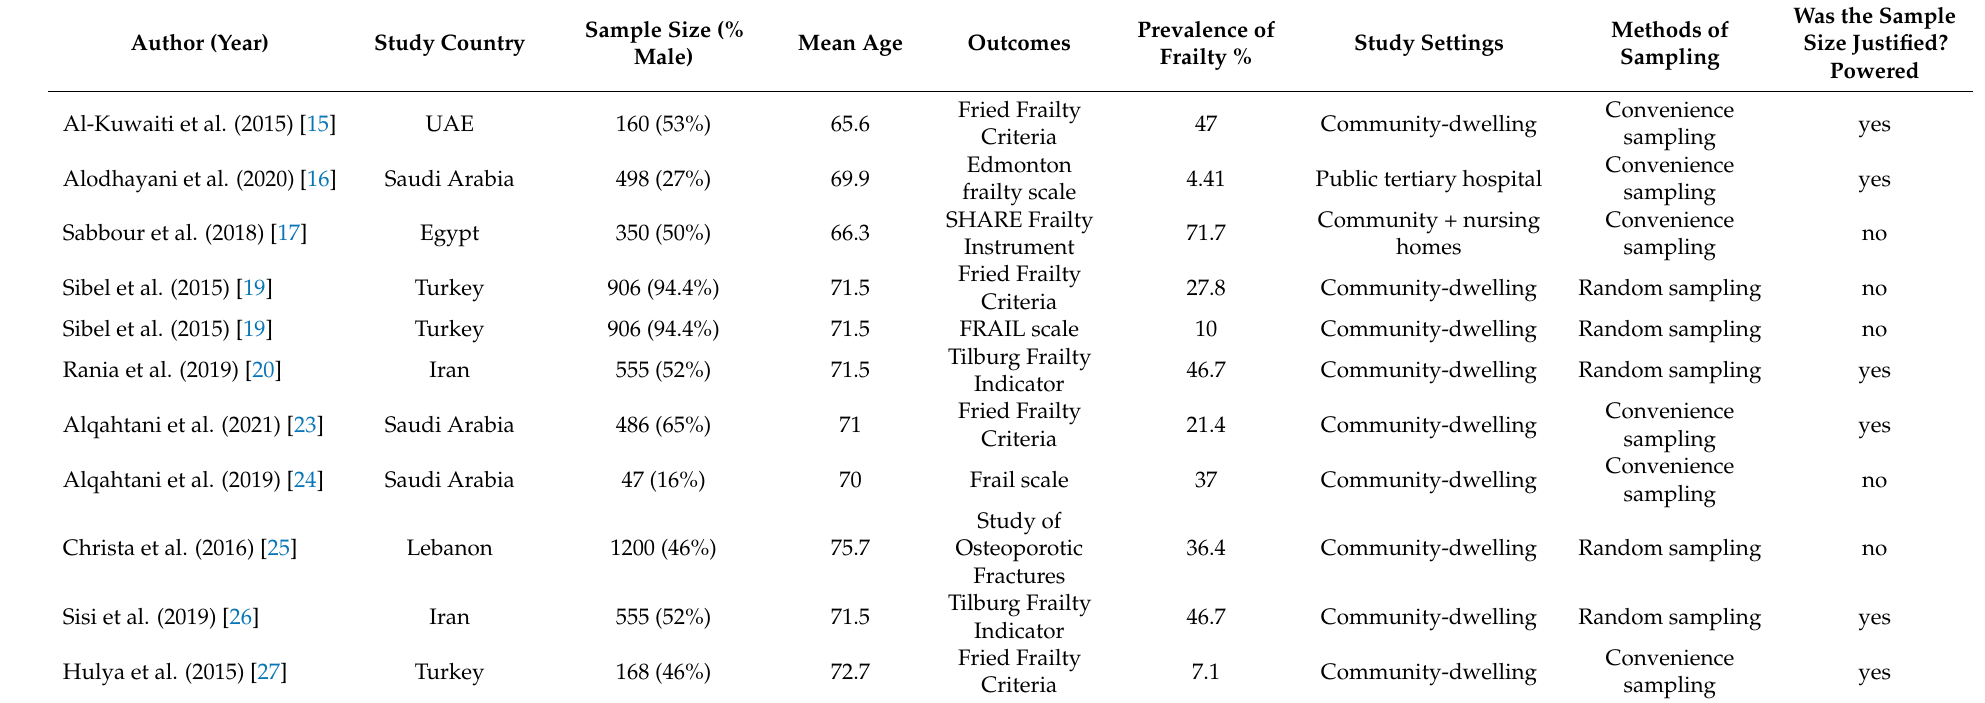
Table 1. Characteristics of studies included in the systematic